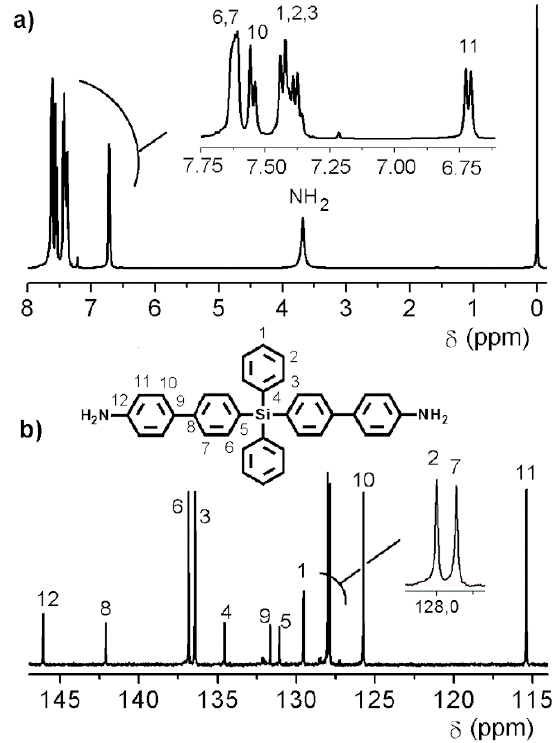
Figure 1. NMR spectra (CDCl 3 ) of diamine A2. ( a ) 1 H NMR, ( b ) 13 C NMR.